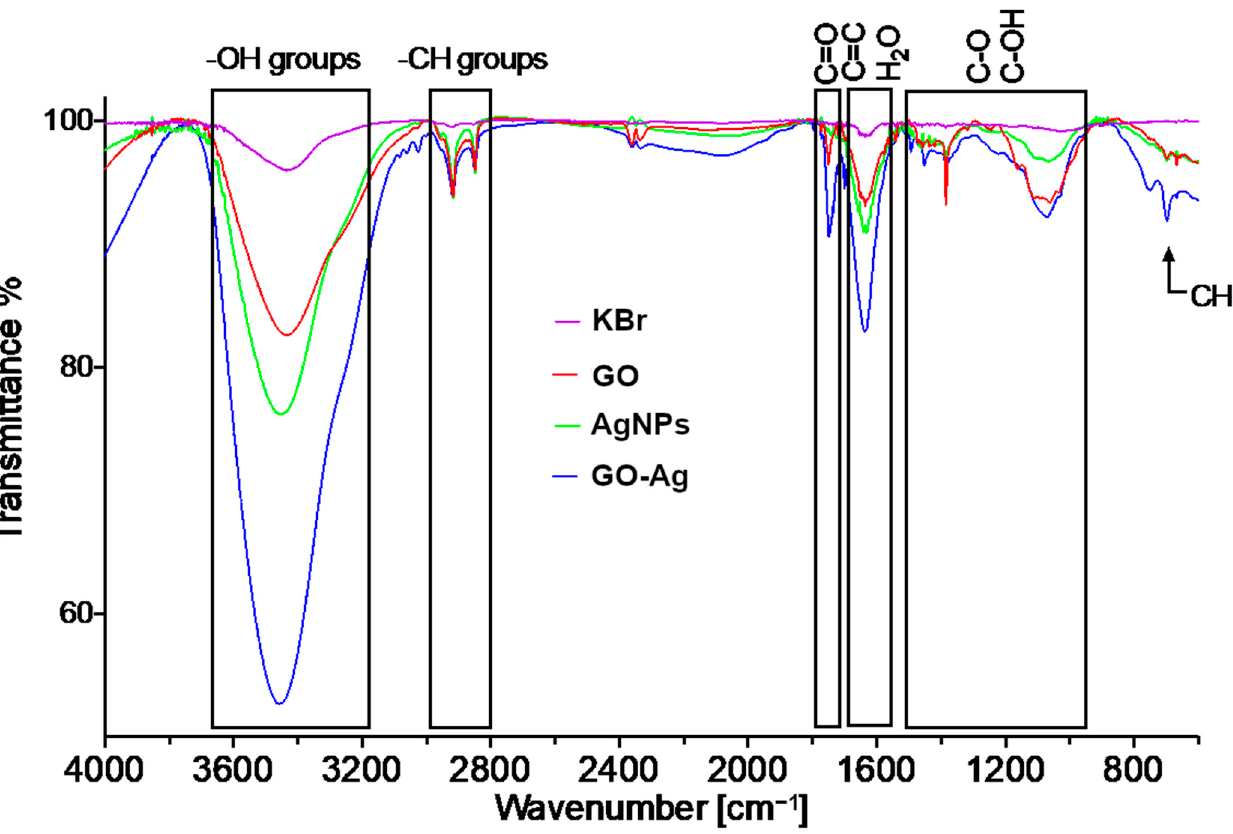
Figure 2. FT-IR transmittance spectrum of graphene oxide (GO), silver (AgNPs) and GO with AgNP complexes (GO-Ag) in comparison to KBr spectrum.